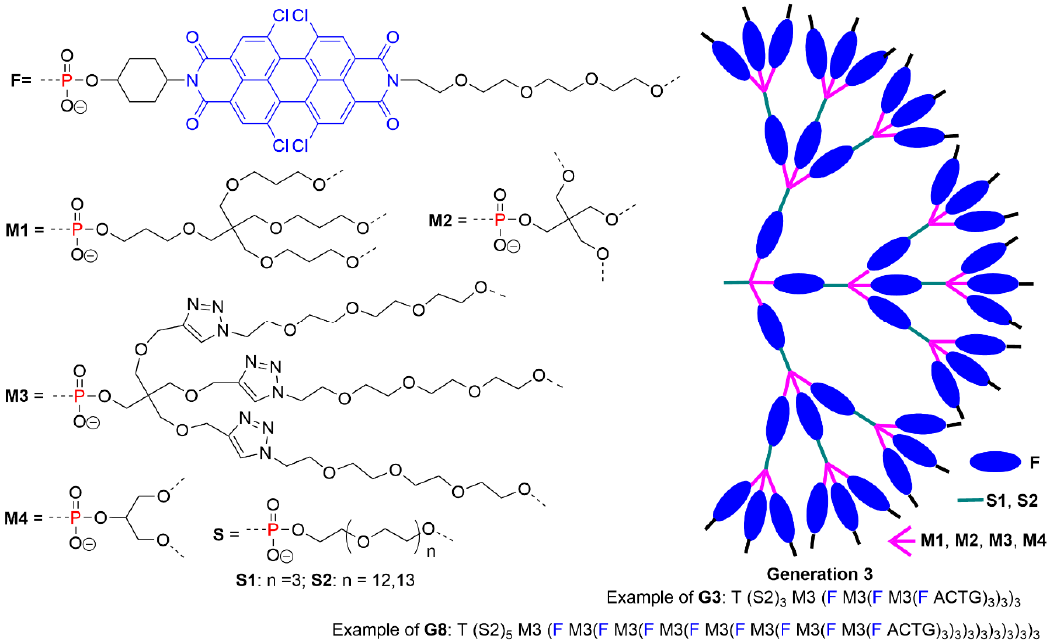
Figure 6. The various building blocks based on phosphoramidite reagents used for the synthesis of dendrimers built with perylenes in the branches, and schematization of the type of dendrimers obtained.